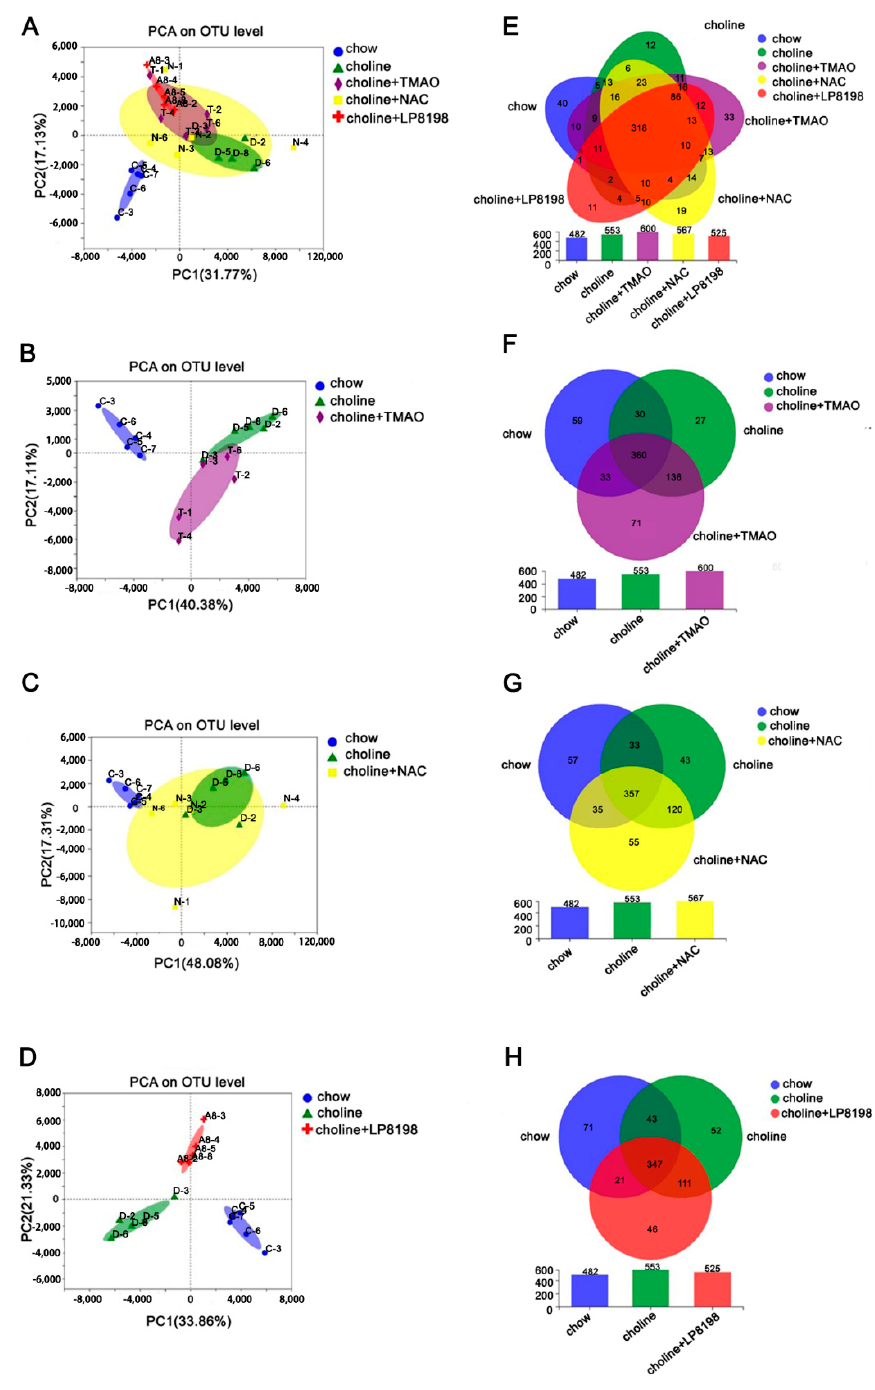
Figure 7. PCA and species composition analysis of the intestinal flora in C57BL/6 mice. ( A ) PCA analysis of all samples. ( B ) PCA analysis of chow ‐ diet group, choline ‐ diet group and choline ‐ diet+TMAO group. ( C ) PCA analysis of the chow ‐ diet group, choline ‐ diet group and choline ‐ diet+NAC group. ( D ) PCA analysis of chow ‐ diet group, choline ‐ diet group and choline ‐ diet+LP 8198 group. ( E ) Venn diagram analysis of all samples. ( F ) Venn diagram analysis of chow ‐ diet group, choline ‐ diet group and choline ‐ diet+TMAO group. ( G ) Venn diagram analysis of chow ‐ diet group, choline ‐ diet group and choline ‐ diet+NAC group. ( H )Venn diagram analysis of chow ‐ diet group, choline ‐ diet group and choline ‐ diet+LP 8198 group. n = 5 per group.